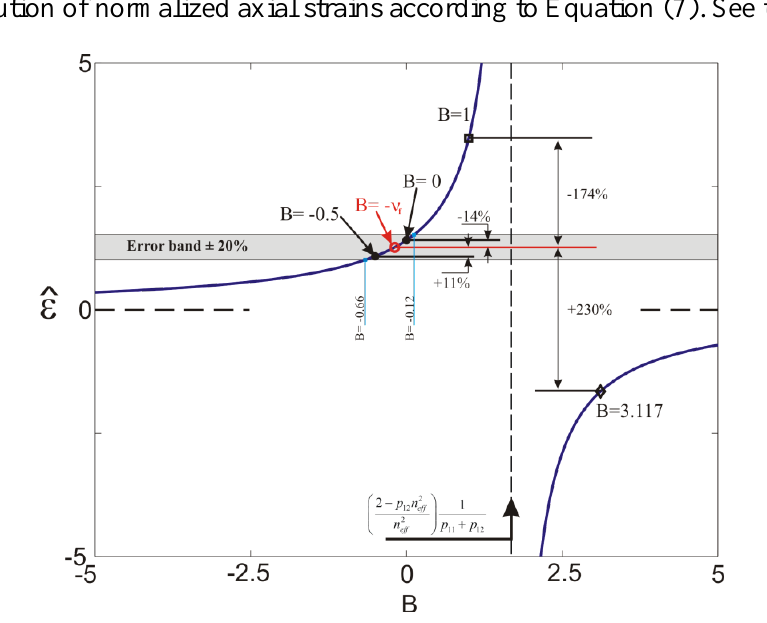
Figure 2. Evolution of normalized axial strains according to Equation (7). See text for